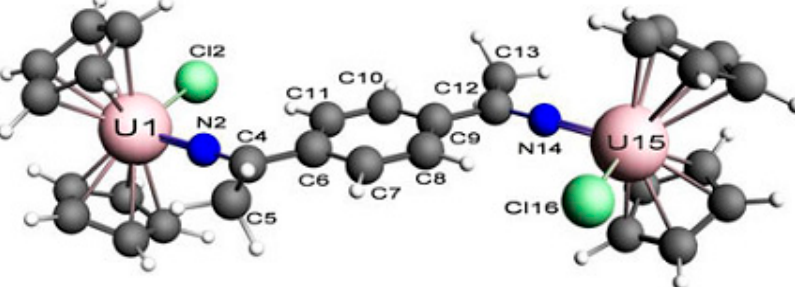
Figure 14. Structures of the bis(ketimide) diuranium(IV) complexes (reprinted with permission from [147], Springer-Verlag, 2012).